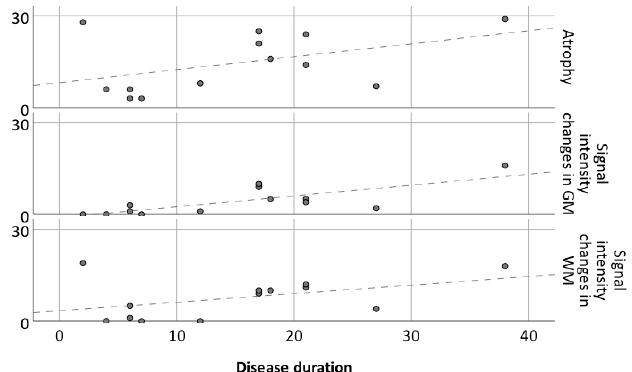
Figure 2. Atrophy and signal intensity changes in gray and white matter in relation to disease duration for 13 patients. Dashed lines represent linear regression for atrophy, GM SI changes and WM SI changes.